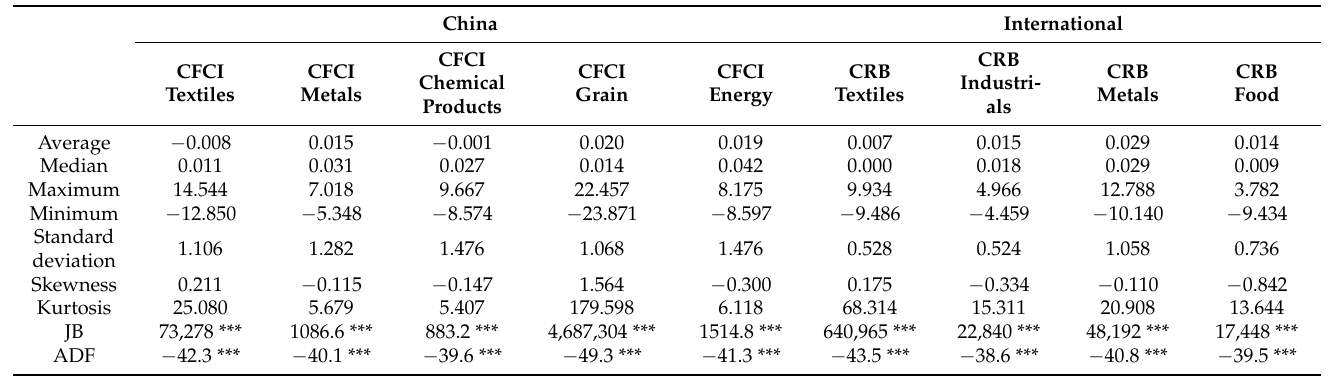
Table 1. Descriptive statistics of the logarithmic yields.